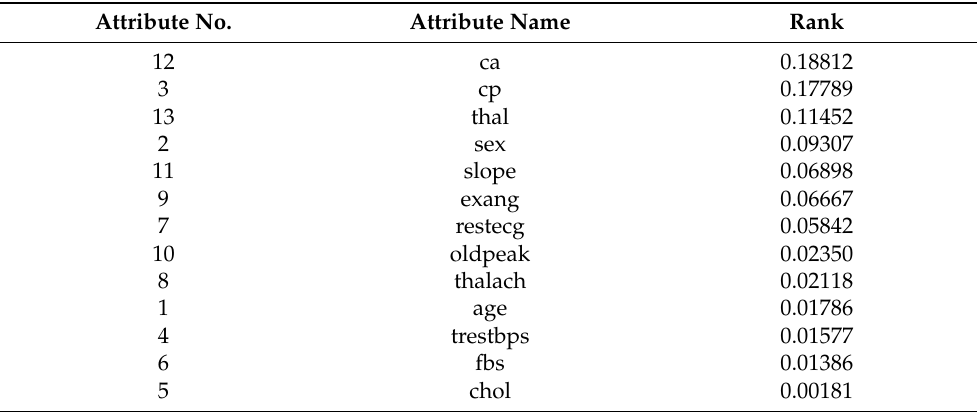
Table 5. Attribute sets that were obtained from the ReliefF attribute evaluation.